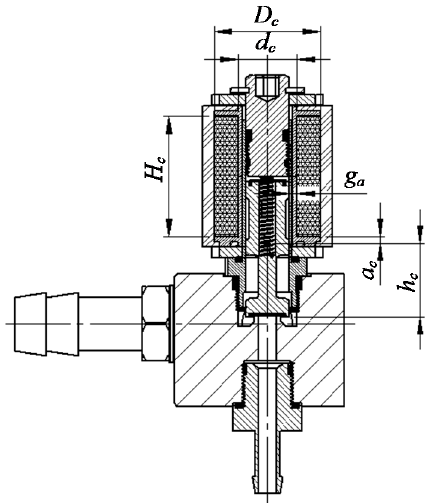
Figure 3. The generic scheme for calculating the inductance of the Valtek Rail Type-30 electromagnetic circuit: a c —distance of the plunger center of mass from the edge of the coil; d c —internal diameter of the coil; D c —outer diameter of the coil; g a —air gap between the plunger and the inner edge of the coil; H c —coil length; h c —length of plunger outside the valve cabinet.